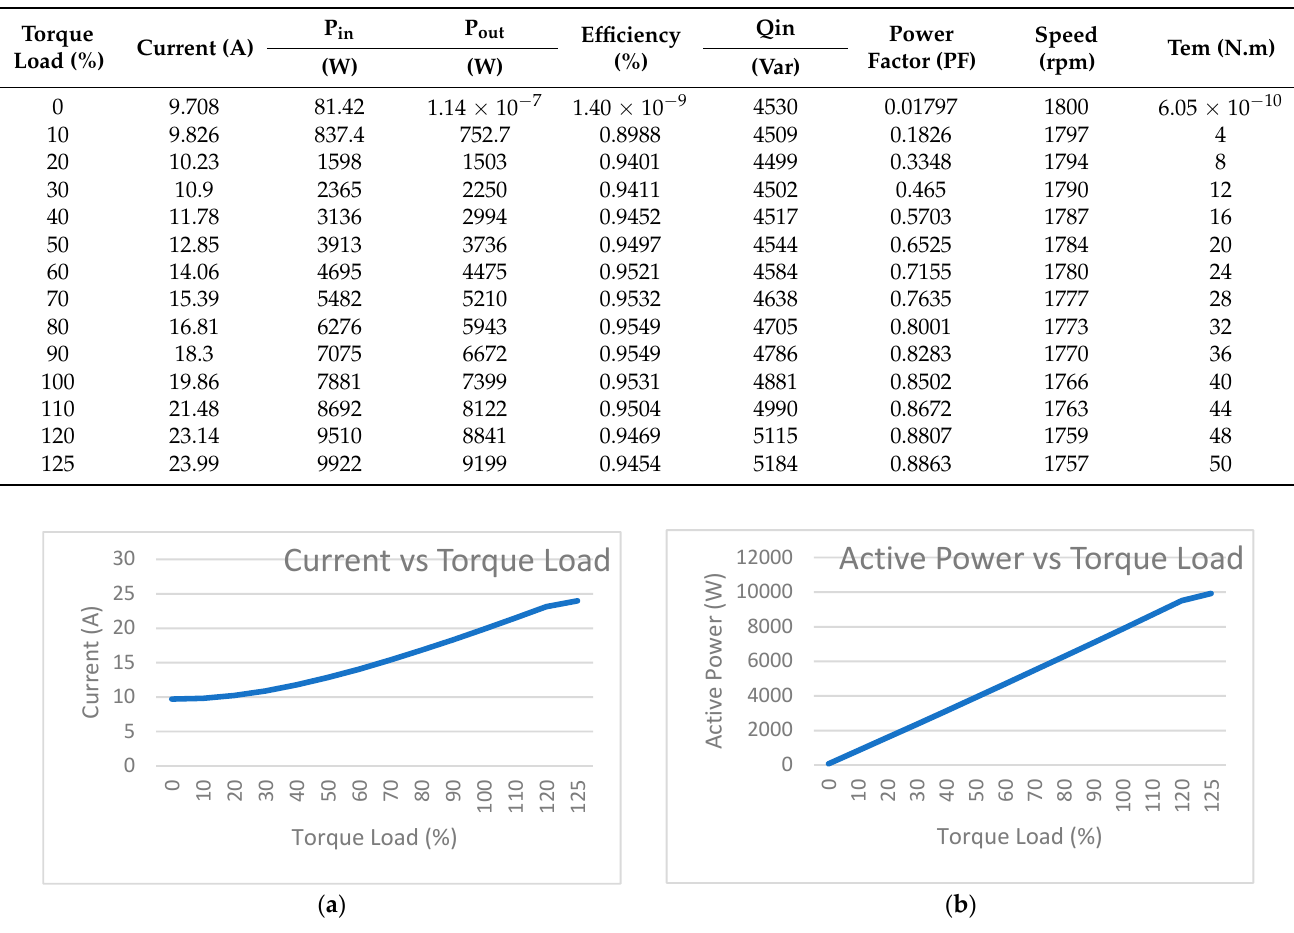
Table 2. The induction machine’s results.